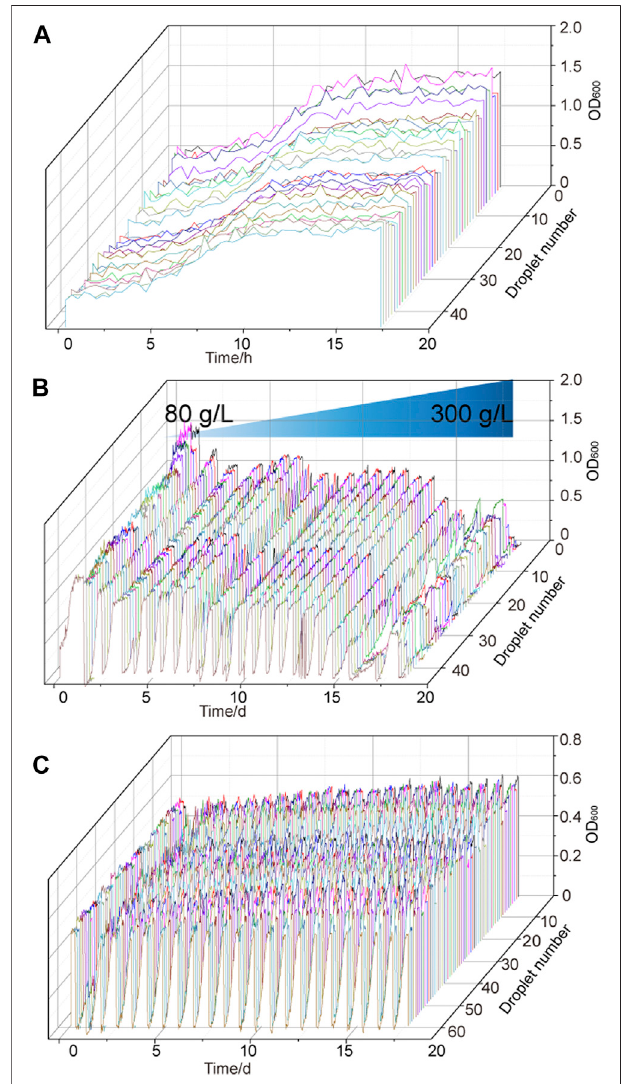
FIGURE 3 | Adaptive evolutionary growth curve of G. oxydan s. (A) Growth curve of G. oxydans WSH-004 in MMC. (B) Growth curve of G.oxydans in adaptive evolution. (C) Adaptive evolution of G. oxydans was carried out in a high-concentration D-sorbitol medium. The controlled passage time was 15 h, the culture temperature was 30 ° C, and the continuous passage of G. oxydans in MMC lasted for 15